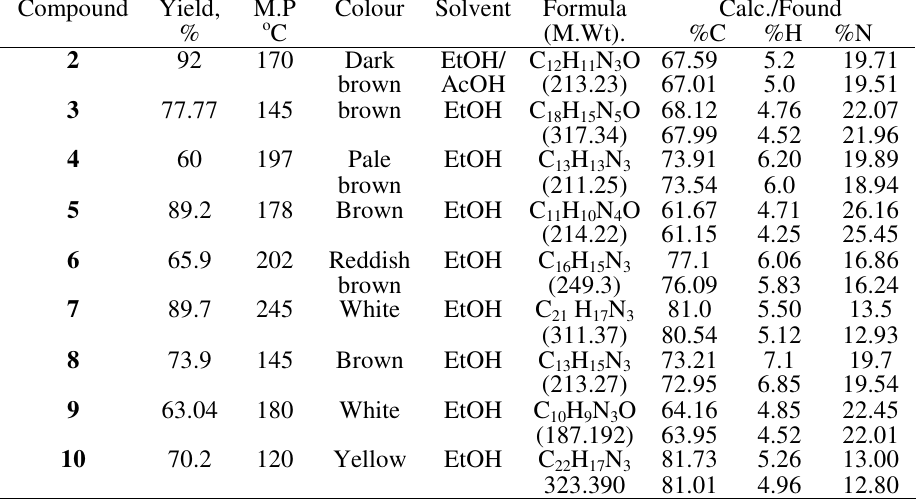
Table 1. Characterization data of the